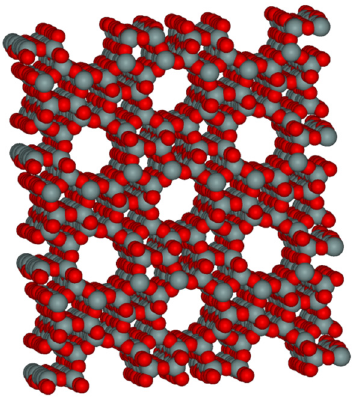
Figure 5. Microporous molecular structure of ZSM-5.